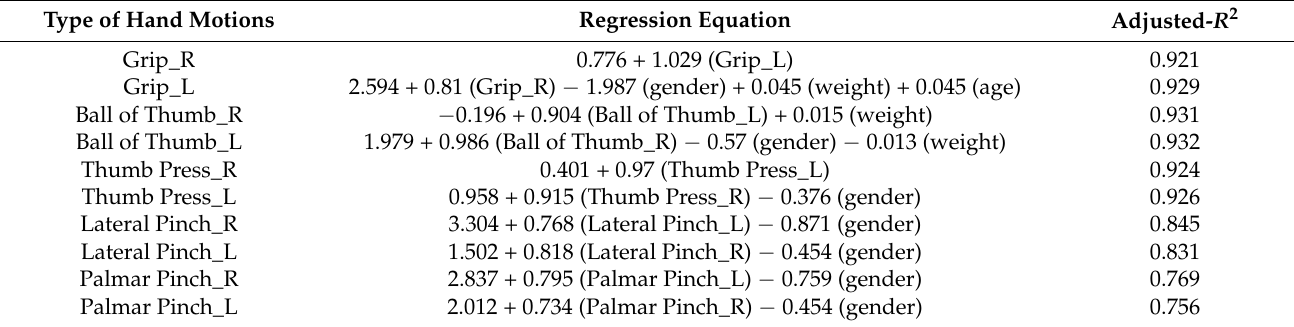
Table 3. Prediction models using the strength of the opposite hand and demographic